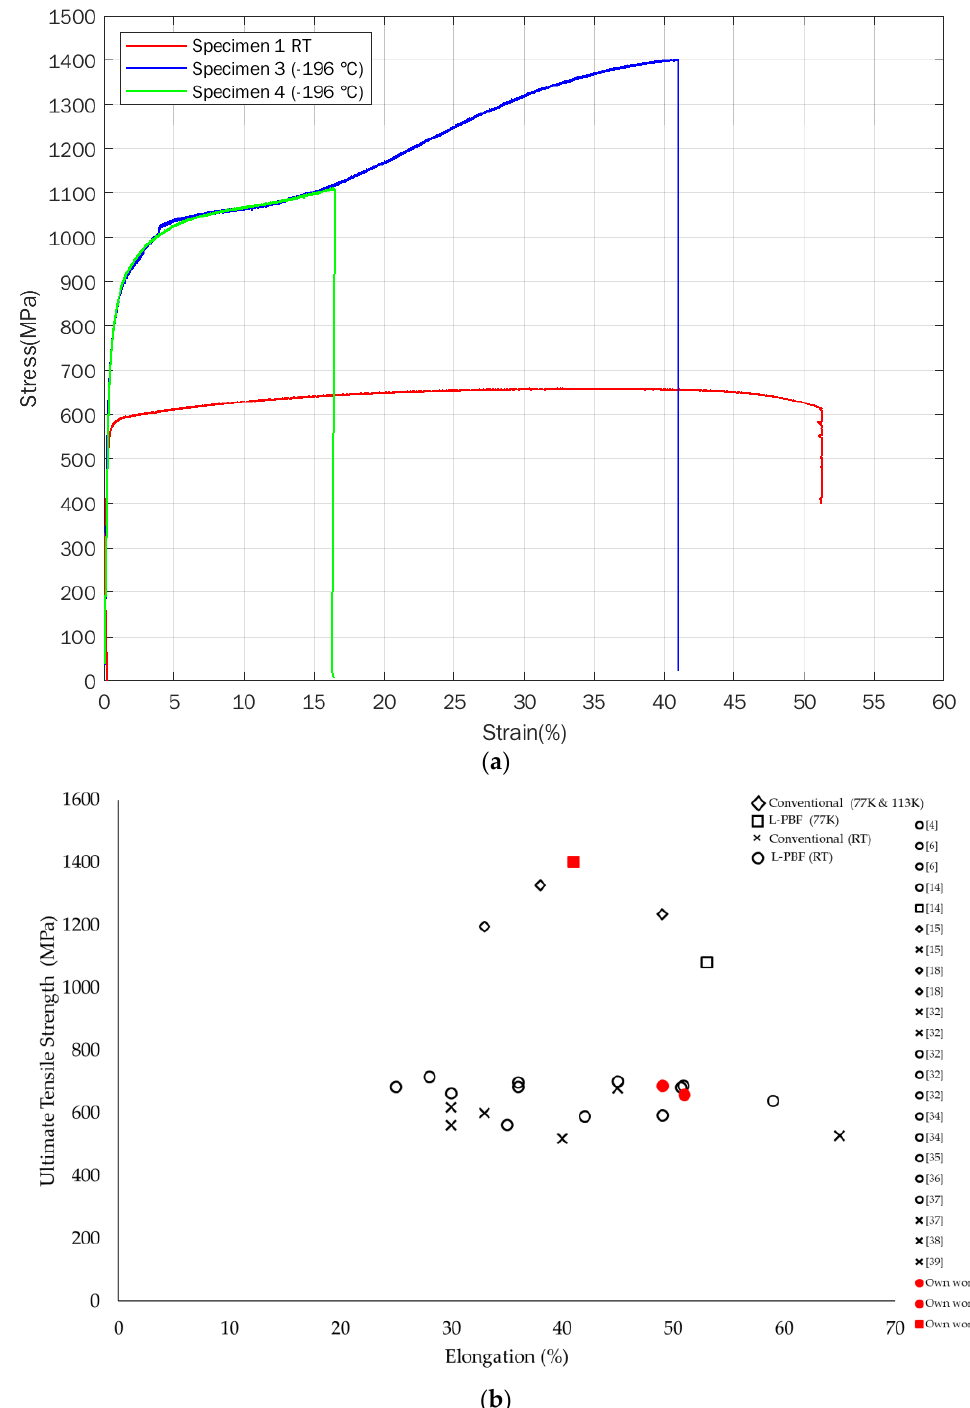
Figure 2. ( a ) Stress – strain curves for L-PBF-processed 316 L stainless steel at room temperature (RT) specimen 1 and − 196 °C temperature specimens 3 and 4. ( b ) Comparison graph of ultimate tensile strength versus elongation for various 316 alloys conventionally built and L-PBF processed, at room and cryogenic temperatures, including own work. Table 3. Mechanical properties at room temperature and at − 196 °C.